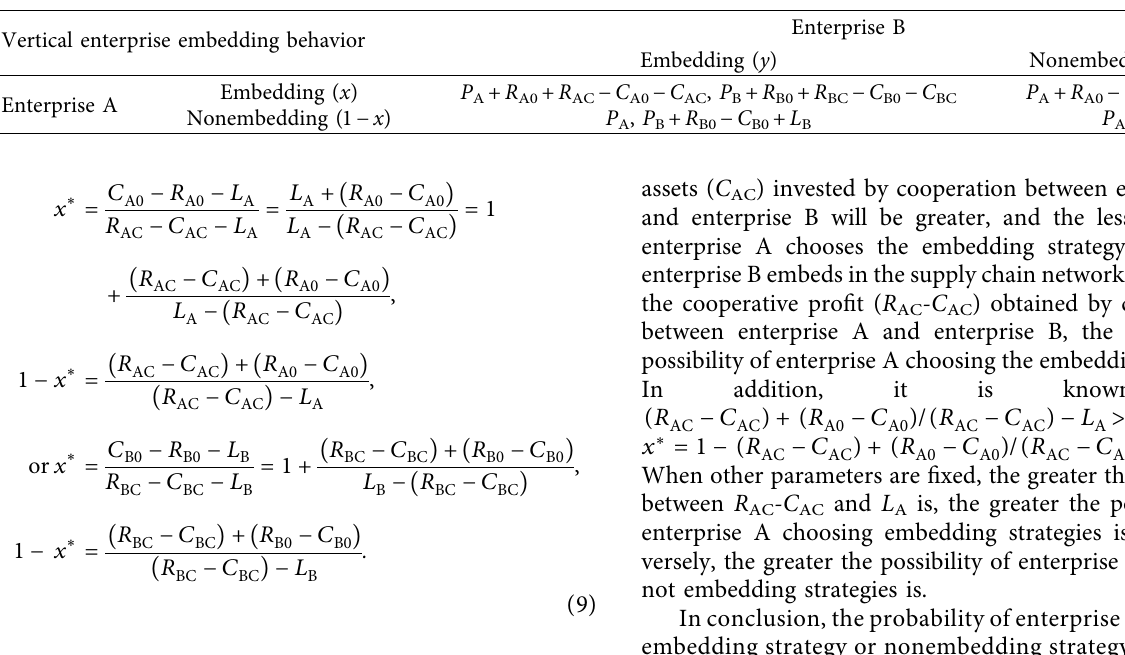
Table 1: Revenue matrix of horizontal